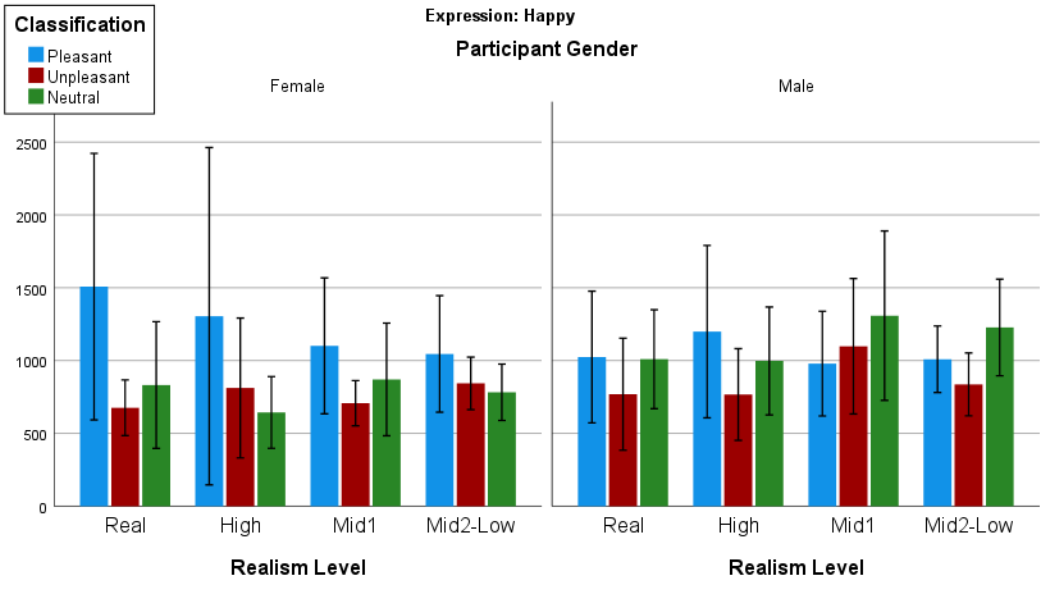
Figure 10. Mean valid responses by participant bio sex for avatars with happy expressions grouped by realism level.